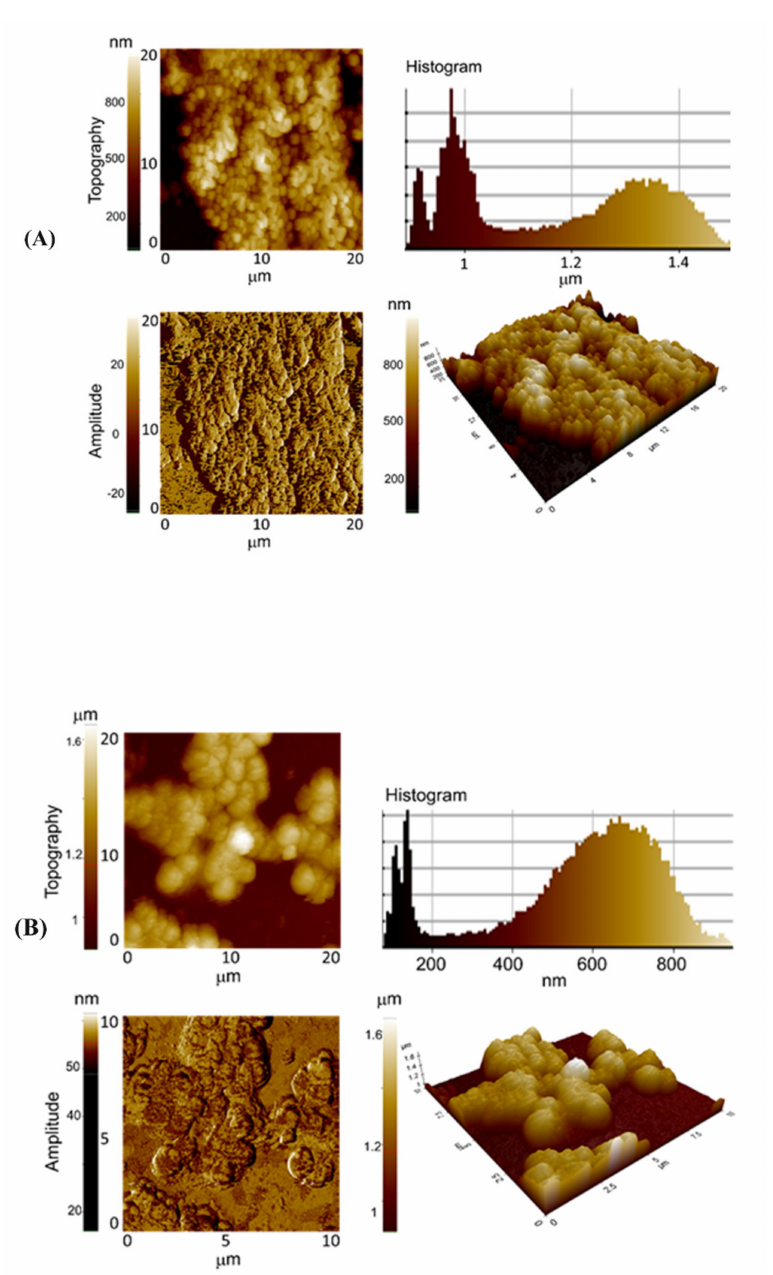
Figure 9. Representative AFM (topography, histogram, 3D, and amplitude) images of S. aureus after incubation with the 200 µ g/mL rGO-S/Se NPs. S. aureus in the absence of NPs was taken as the positive control. ( A , B ) S. aureus after 8 h incubation with rGO-S/Se NPs, Scale bar = 10 µ